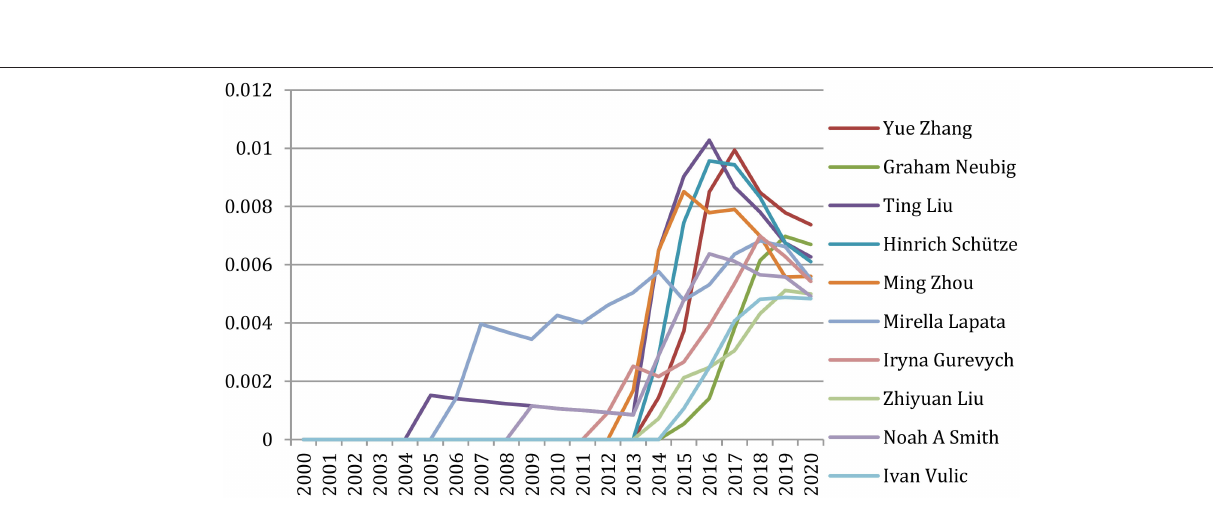
FIGURE 48 | Cumulative authors’ contributions to the study of “Embedding” in speech and NLP (% of topical papers).